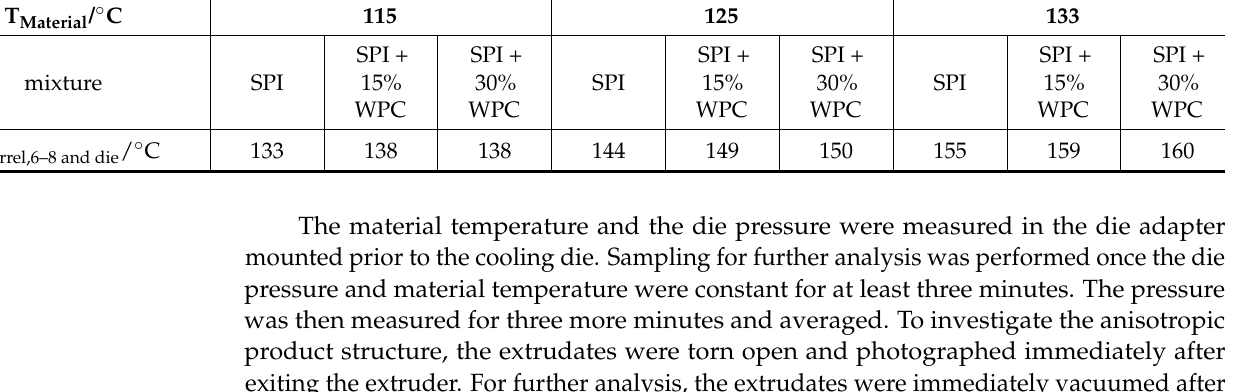
Table 1. Temperature profiles of the extrusion trials. Temperature of the barrels 6–8 and the die adapter were specifically adjusted to achieve material temperatures of 115, 125 and 133 ◦ C for each material system. T Material / ◦ C